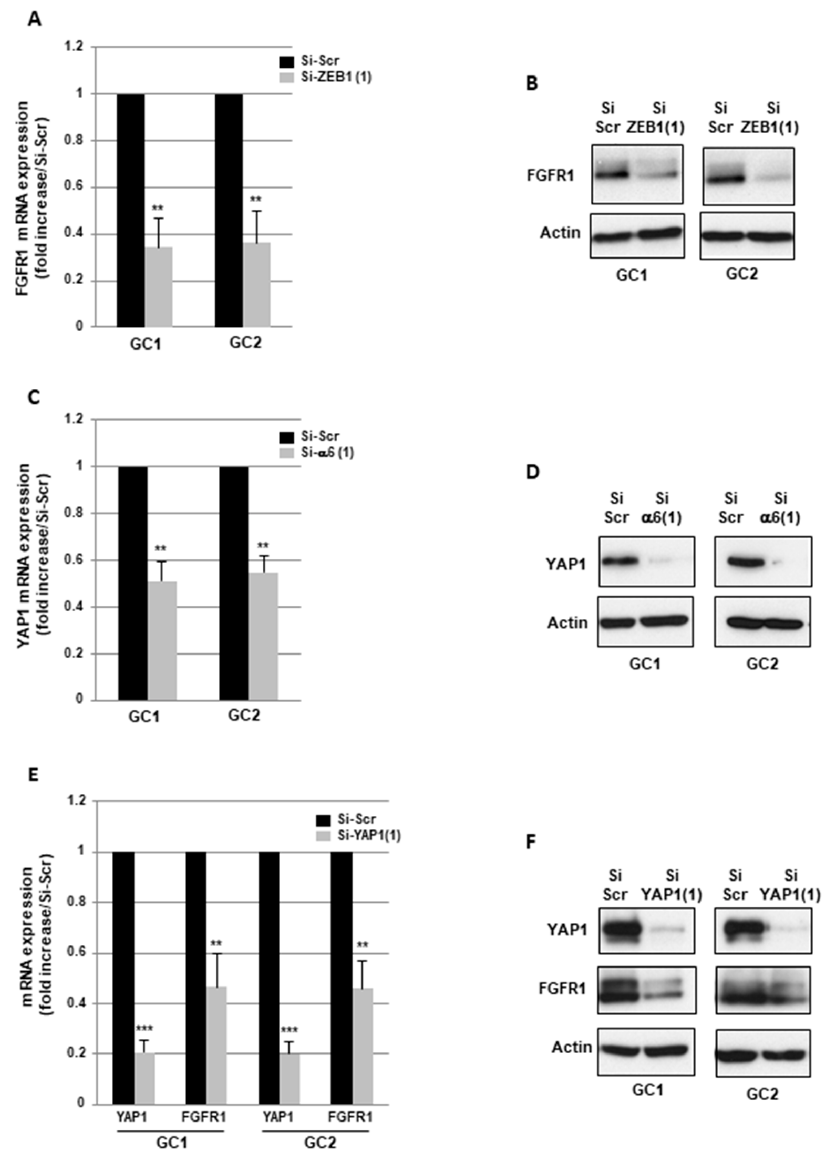
Figure 5. The transcription complex ZEB1/YAP1 regulates FGFR1 expression. ( A – F ) GBMSC derived from GBM biopsy specimens (GC1, GC2) were transfected with a ZEB1 siRNA (si-ZEB1(1)), an α 6-integrin siRNA (si- α 6 (1)), a YAP1 siRNA (si-YAP1) or a scramble control (si-Scr). ( A , C , E ) the expression of FGFR1 or YAP1 was analyzed by real-time PCR. Quantifications of 3 independent experiments are presented as means ± SD. *** p < 0.001; ** 0.001 < p < 0.01. ( B , D , F ) FGFR1 and YAP1 proteins expression were analyzed using Western blot. Images are representative of 3 independent experiments. Actin was used as a loading control.